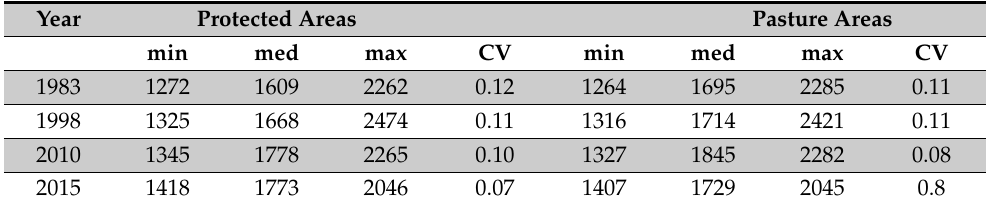
Table 4. Descriptive statistics of precipitation (mm.year − 1 ) for years 1983, 1998, 2010 and 2015 presenting minimum, medium and maximum values for protected and pasture